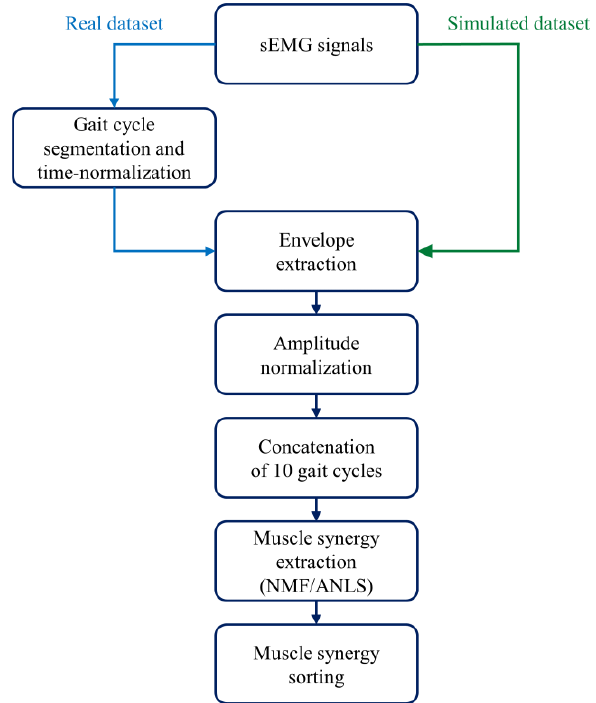
Figure 2. Data processing: steps to extract muscle synergies from the sEMG signals.